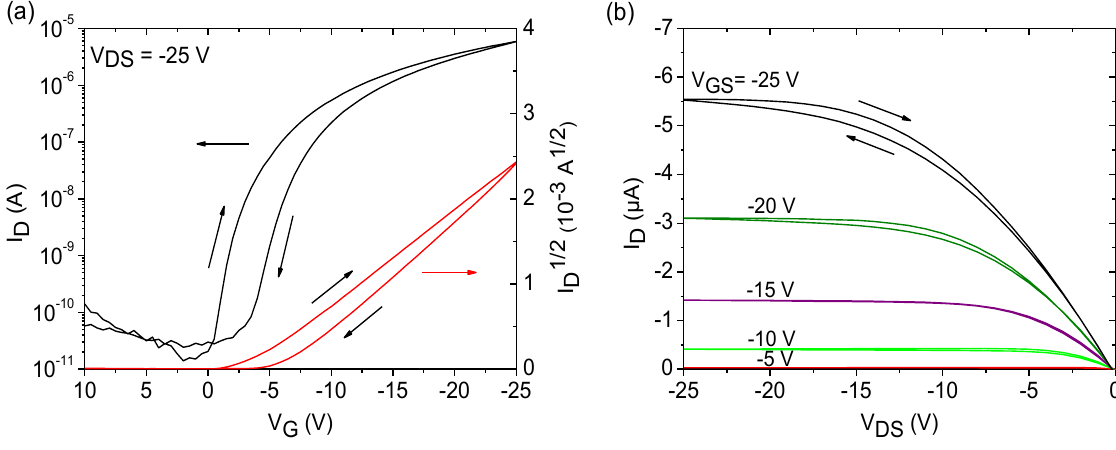
Figure 9. ( a ) Transfer and ( b ) output curve of organic transistors based on automated dispensing of FS111 on SU-8 dielectrics on PEN